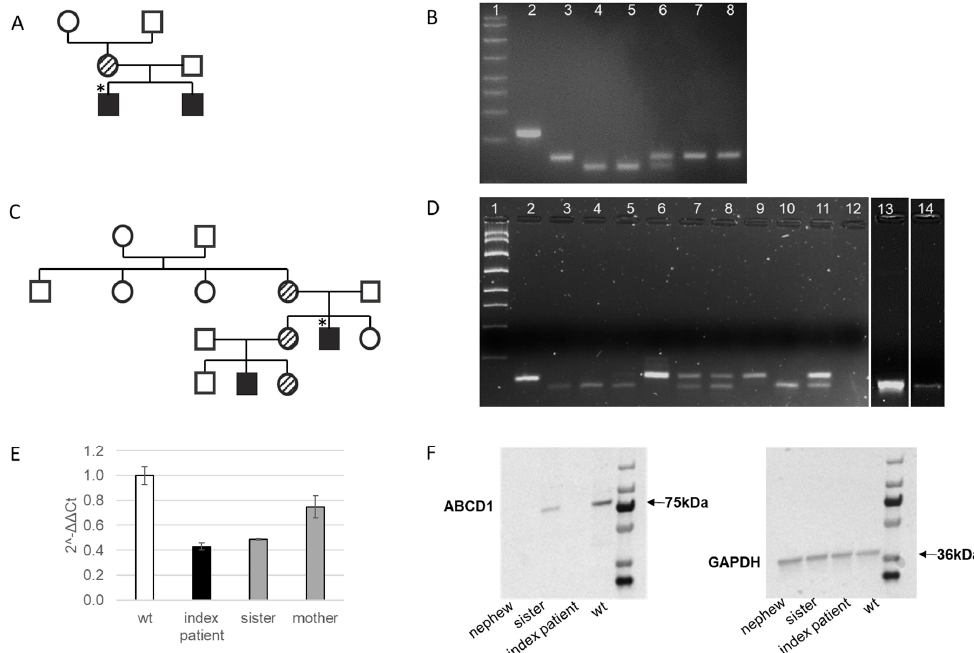
Figure 2. Pedigree analysis of the c.253delC variant ( A ) performed by a restriction digest ( B ) and for c.1275delA novel variant ( C , D ). ABCD1 mRNA expression in the index patient and heterozygous sister and mother in comparison to wild type WT. Expression of GAPDH was used for normalization ( E ). Immunoblot of the index patient and heterozygous sister in comparison to control; GAPDH was used as a loading control ( F ). Lines on the gel in ( B ): (1) standard, (2) PCR product, (3) WT, (4) Index patient, (5) affected brother, (6) mother (heterozygous), (7) grandmother (WT), grandfather (WT). Lines on the gel in ( D ): (1) standard, (2) PCR product, (3–5) WT, (6) Index patient, (7) sister (heterozygous), (8) mother (heterozygous), (9) nephew (affected), (10) nephew (WT), (11) niece (heterozygous), (12) no template control, (13) father (WT), (14) sister (WT). * Indicates the index patient in the